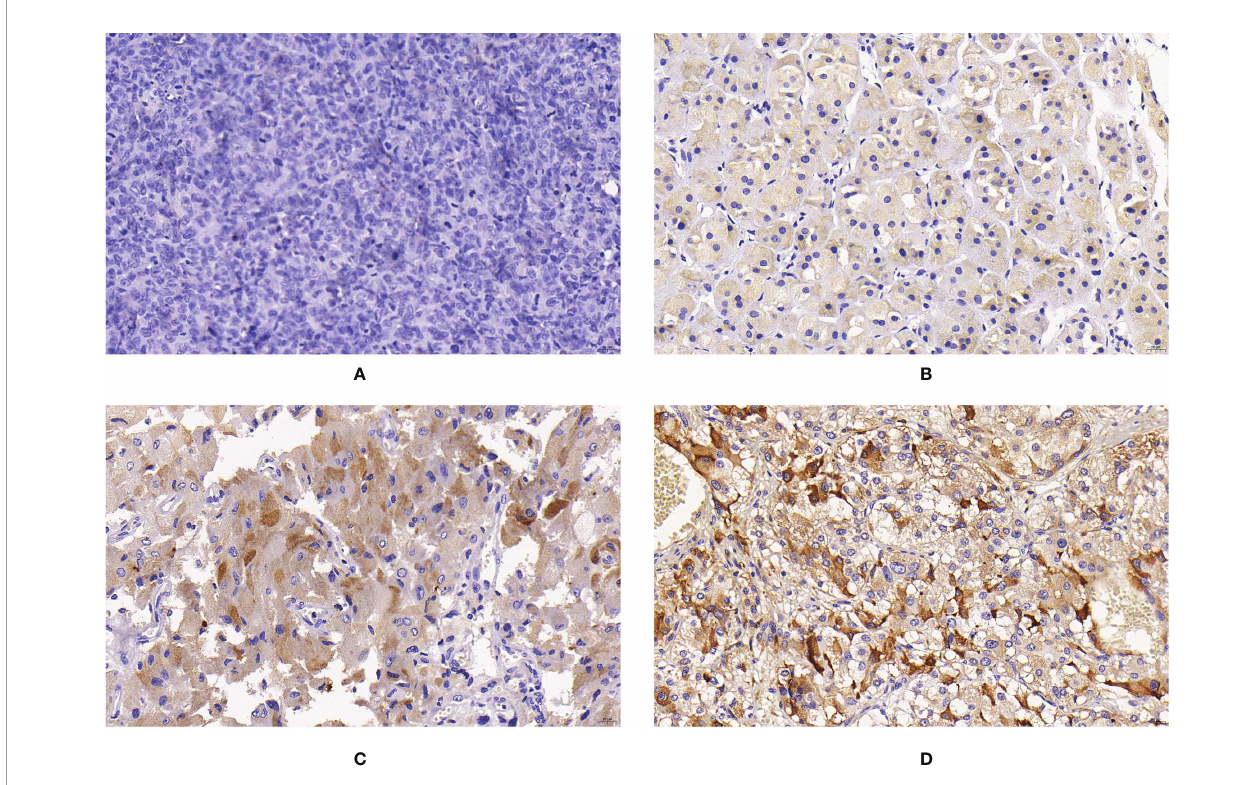
FIGURE 5 | Expression of CHGB in PPGLs. (A) Negative immunostaining of CHGB in PPGLs. (B) Weakly positive immunostaining of CHGB in PPGLs. (C) Intermediately positive immunostaining of CHGB in PPGLs. (D) Strongly positive immunostaining of CHGB in PPGLs.